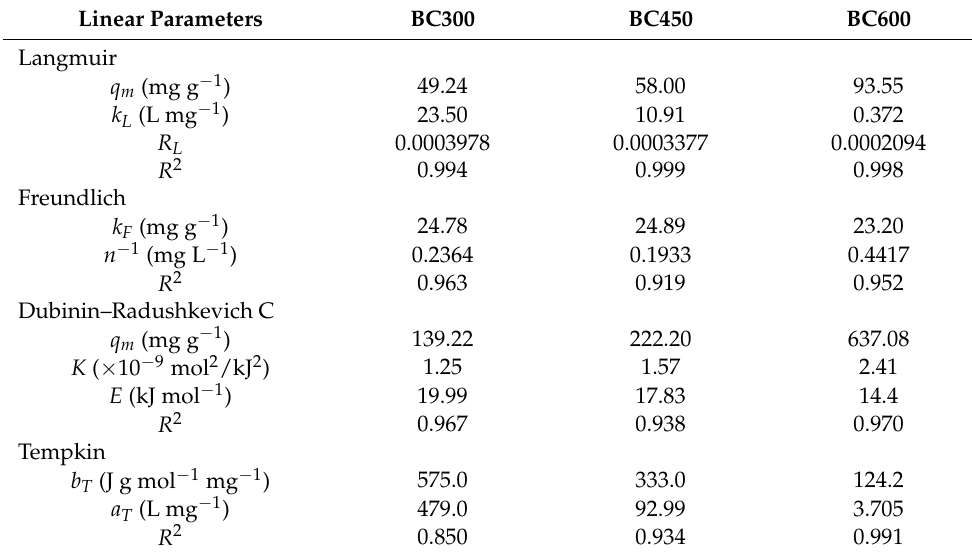
Table 4. Adsorption isotherm parameters of the Langmuir, Freundlich, Dubinin–Radushkevich, and Temkin models determined for the biochar samples from Macrocystis pyrifera under study. Linear Parameters